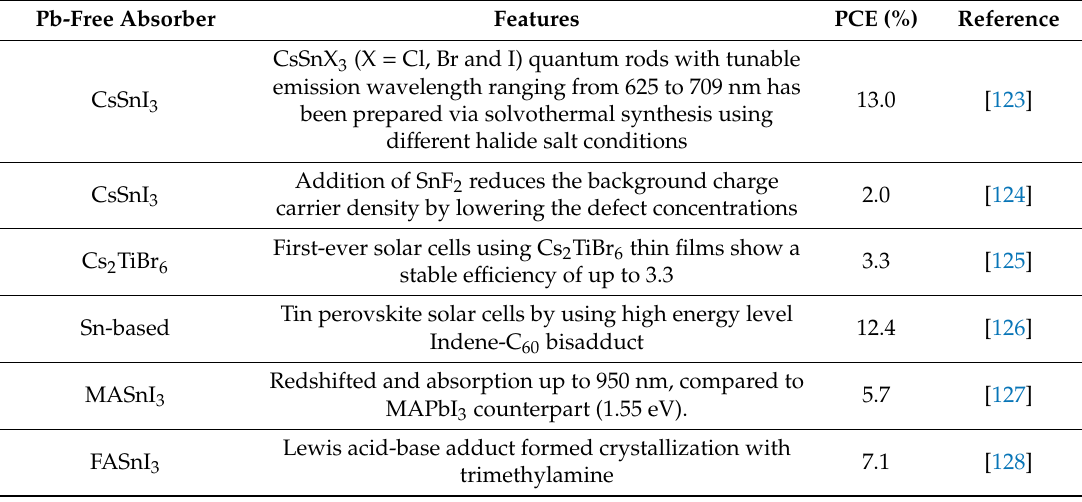
Table 4. Significant performance of various lead-free perovskite-based materials in PSCs. Pb-Free